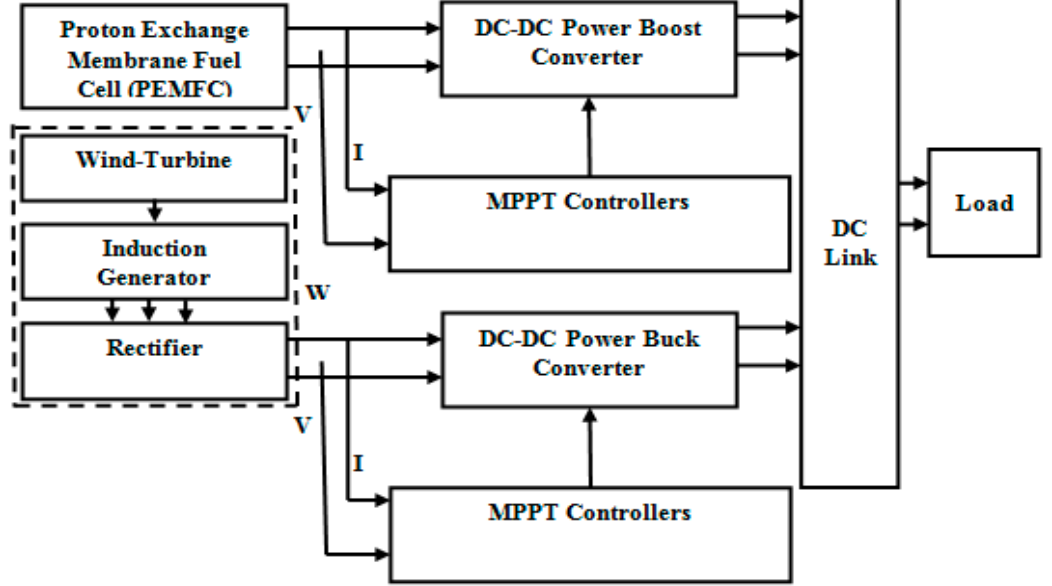
Figure 4. Proposed combination of FC–W systems with different MPPT controllers.